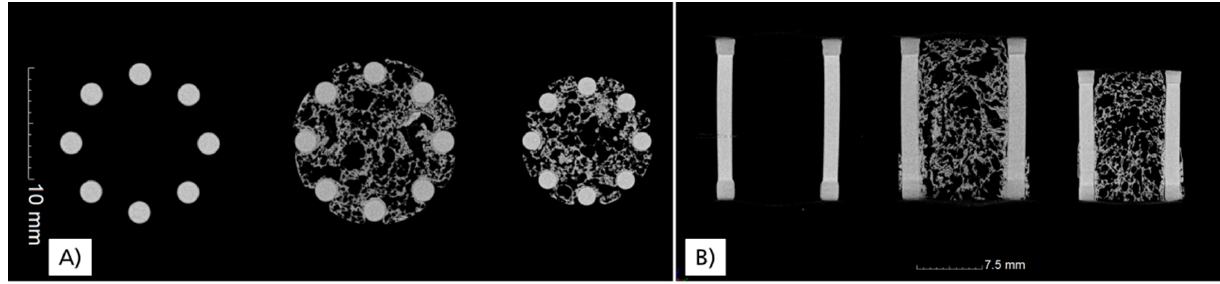
Figure 4. CT images of an exemplary hybrid structure; from left to right: left: VPP support structure (green state); middle: hybrid (green state); right: sintered hybrid ( A : plan view, B : side view).